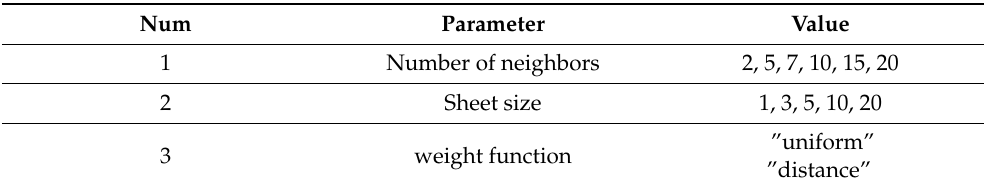
Table 4. Parameters for the k-nearest neighbor model.